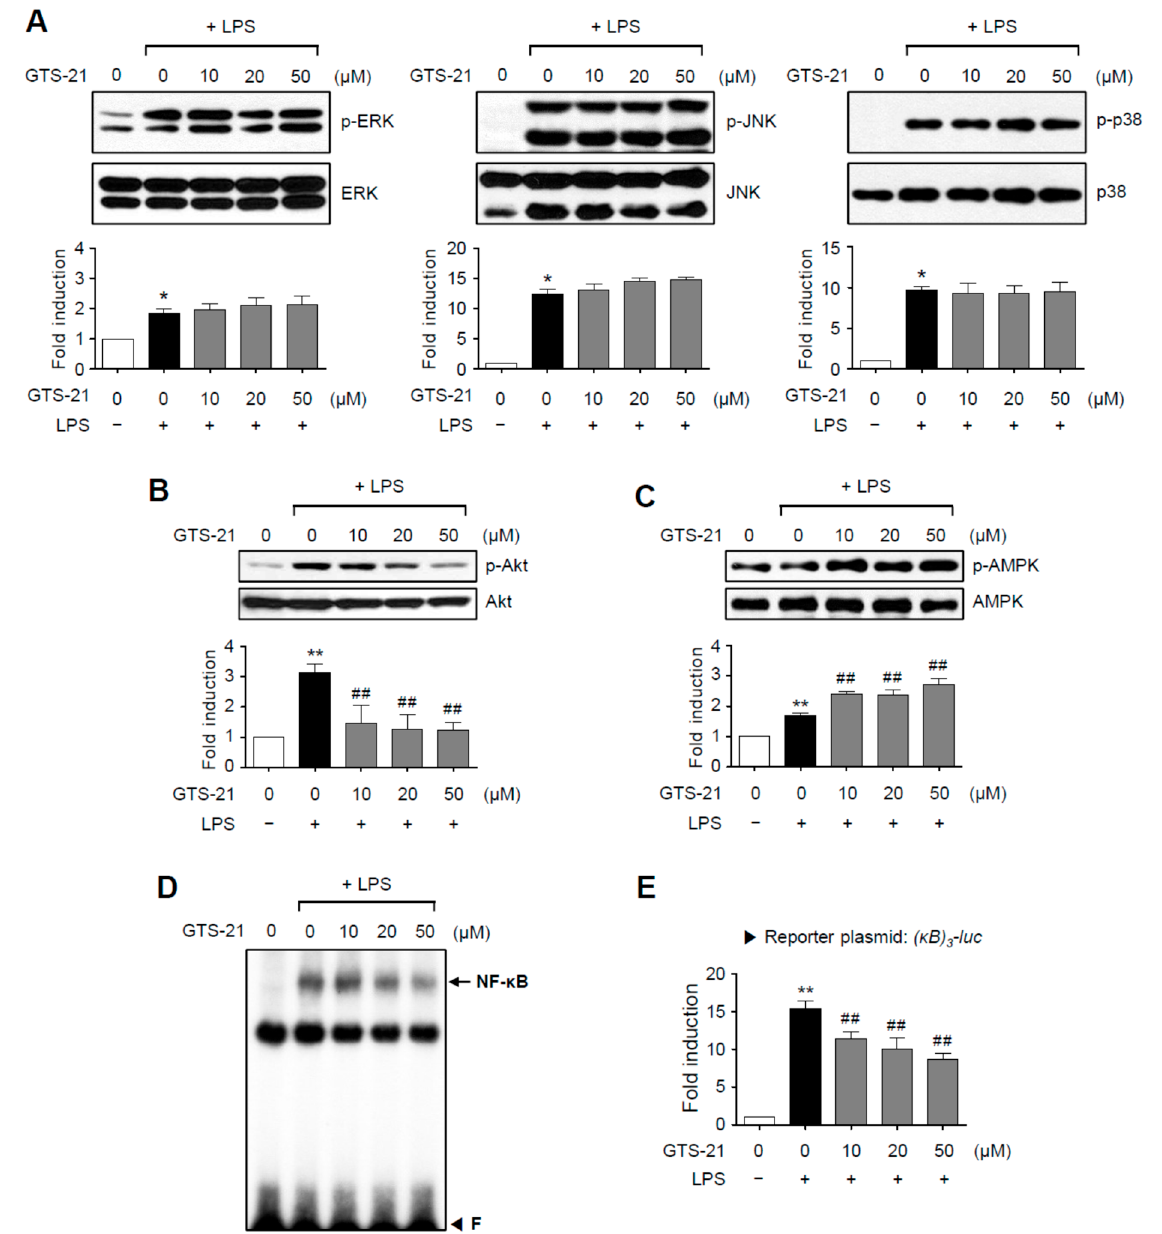
Figure 2. Effect of GTS-21 on the activities of MAPKs, Akt, AMPK, and NF- κ B in LPS-stimulated BV2 cells. ( A – C ) Cell lysates from BV2 cells treated with LPS for 30 min in the presence or absence